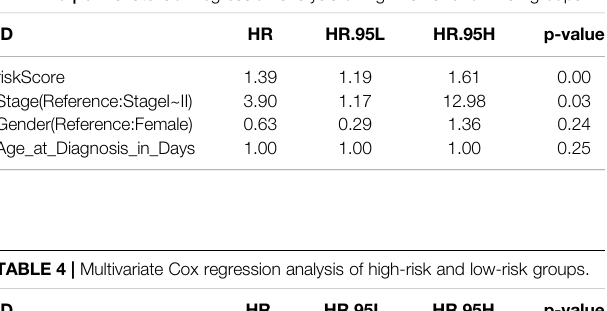
TABLE 3 | Univariate Cox regression analysis of high-risk and low-risk groups.